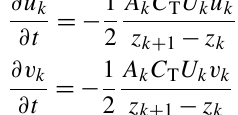
Table 1. A summary of boundary conditions and spinup times for the turbine-free idealized